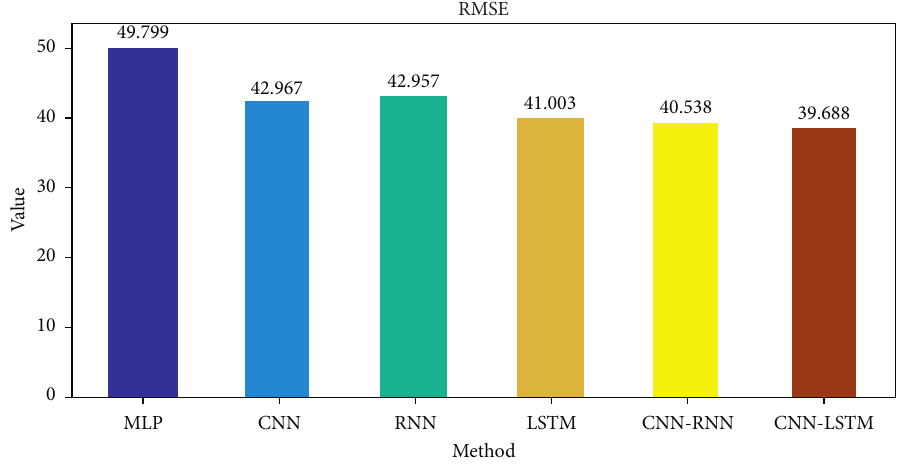
Figure 12: The result of RMSE comparison among different methods.